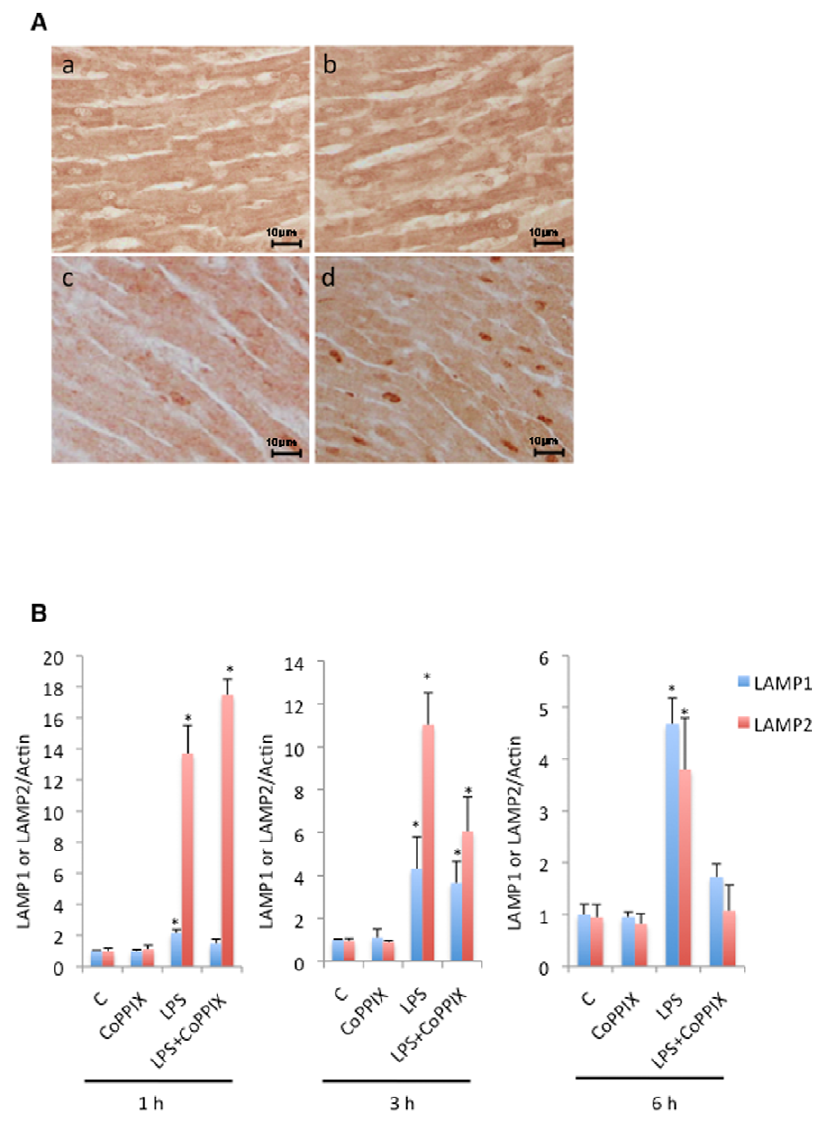
Figure 6. Effects of CoPPIX on nuclear translocation and activation of TFEB during LPS treatment in the rat heart. A, Immunohistochemical analysis of TFEB in the left ventricle of the rat heart at 3 h after LPS administration (15 mg/kg). Representative images in each group are shown: control (a), CoPPIX (b), LPS (c), LPS + CoPPIX (d). Bars, 5 m m. B, RT-PCR analysis of the LAMP1 and LAMP2 levels in the heart of LPS- treated and control animals for 1, 3, and 6 h. Amplification of actin cDNA was performed and served as the internal control. Each bar represents the mean 6 S.E. of three animals (*p , 0.05 vs. none).